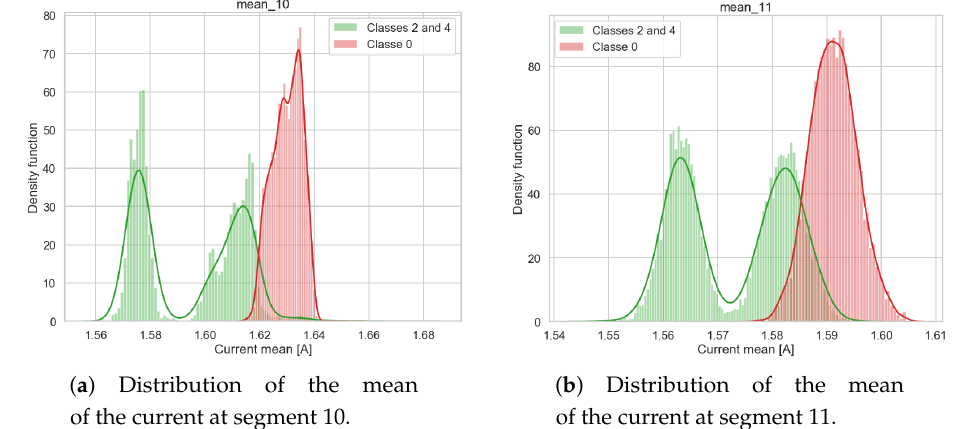
Figure 8. Distributions of the mean of the current signals for segments 10 and 11 for classes 2 and 4 describing the correct functioning of the machinery and for class 0 describing the incorrect functioning of the machinery. The density has been computed exploiting the Gaussian kernel density